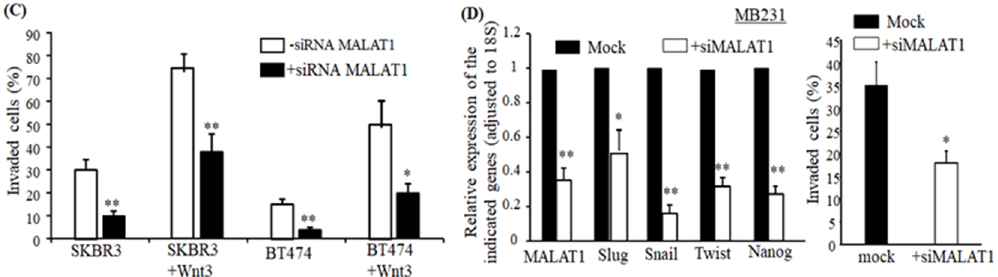
Figure 3. The knockdown of MALAT1 downregulates EMT makers. ( A , B ). Total RNA was extracted from the cells, and gene expression was quantified using RT-qPCR. The bar graphs show levels of the indicated genes relative to 18S. Each bar indicates the mean ± SEM from 4 independent experiments. The knockdown of MALAT1 downregulates EMT markers in the trastuzumab-resistant cells, * p < 0.05 and ** p < 0.01, compared to respective parental cells SKBR3 or BT474, ( A ), or their corresponding mock cell lines ( B ). The ANOVA test was used to determine significance. ( C ). MALAT1 siRNA treatment reduced the number of invaded cells. Cell invasiveness was measured by the Boyden Chamber Invasion assay, as described in the Methods section. The number of invaded cells from the first five random spots was counted. Mean values were calculated from four independent measurements. The bars indicate mean ± SEM. ** p < 0.01 observed when SKBR3 cells compared without siRNA MALAT1 treatment and * p < 0.01 compared to their respective cell lines without siRNA treatment. The ANOVA test was used to determine significance. ( D ). Left-Panel MB231 cells were treated with siRNA MALAT1 or negative sequences (mock) for 72 h. RT-qPCR was used to analyze the indicated genes. Each bar shows the mean ± SEM from four independent experiments. The data suggest siRNA treatment inhibited EMT markers in TNBC cells (* p < 0.05 and ** p < 0.01) compared to mock cells. Right Panel: The bar graph shows a reduced number of invaded cells by MALAt1 siRNA treatment as determined by the Boyden Chamber Invasion assay. Each bar indicates the mean ± SEM from four independent experiments. The number of invaded cells from the first five random spots was counted in each analysis. * p < 0.05 compared to mock cells. The ANOVA test was used to determine significance.